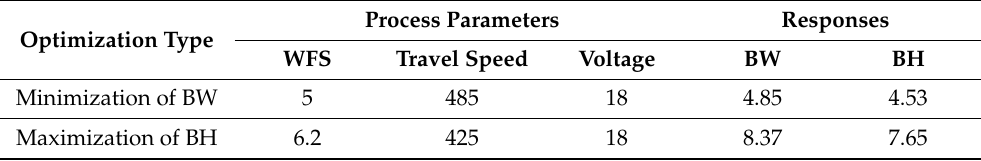
Table 5. Optimized values of BW and BH.